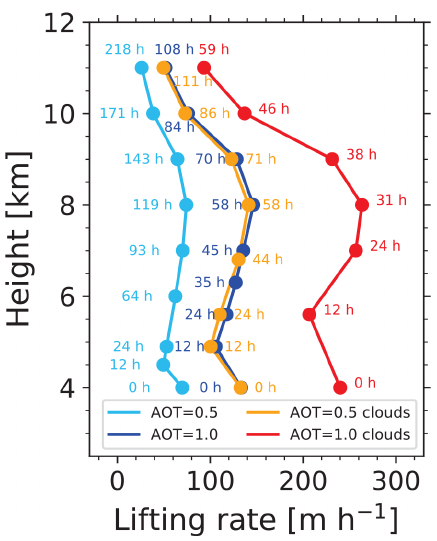
Figure 6. Simulation of self-lifting of Siberian wildfire smoke (in- jected to 3–5km height). The 532nm AOT of the 2km thick smoke layer, initially centred at 4km height, was assumed to be 0.5 and 1.0. Cloud-free (blue curves) and cloudy conditions (orange and red curves, with a cloud deck below the smoke layer, totally reflect- ing incoming solar radiation) are simulated. Smoke is able to reach heights close the tropopause at 10km within about 2–6d (indicated by the hours after ascent start), according to these